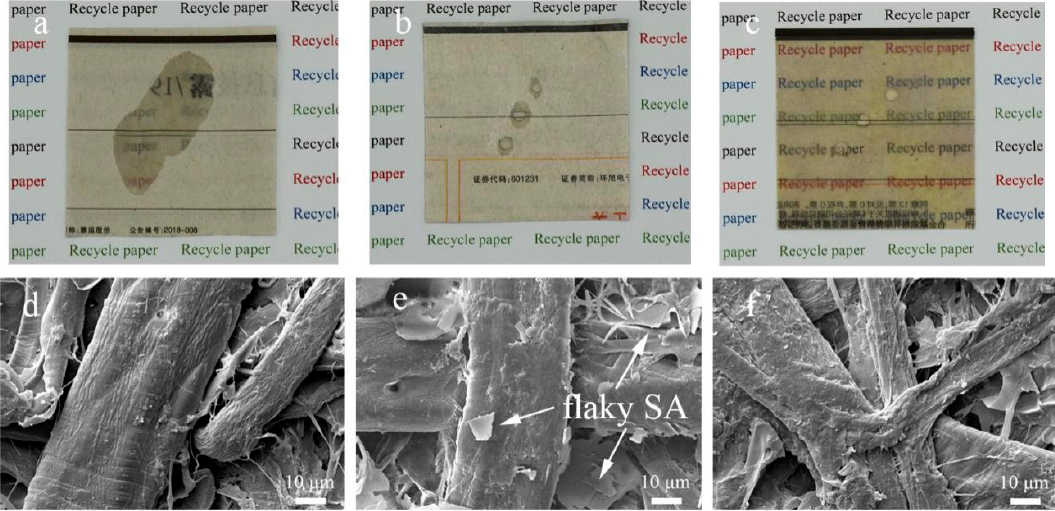
Figure 1. Photographs ( a – c ) and SEM ( d – f ) images of pristine NP ( a , d ), deposited NP ( b , e ) and modified NP ( c , f ).